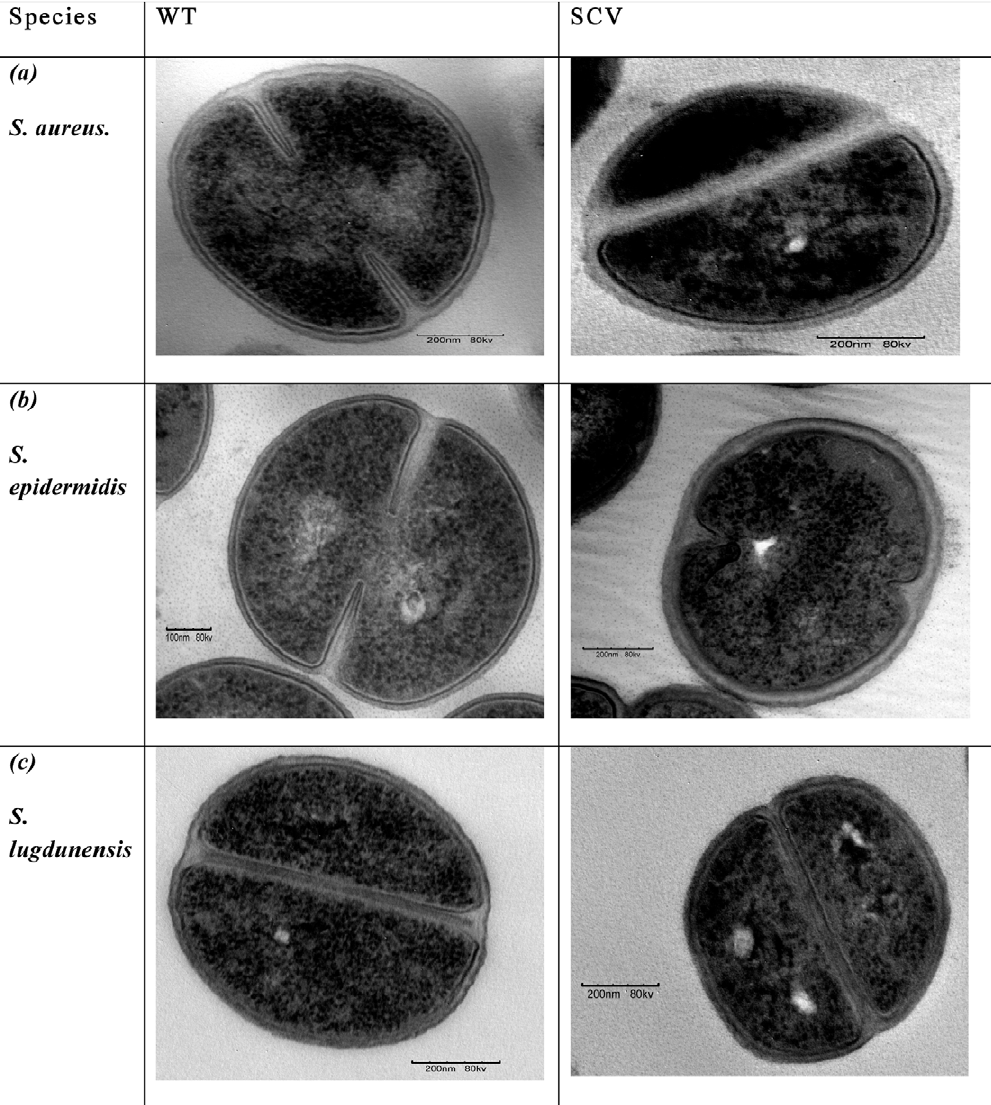
Figure 3. TEM images of (a) S.aureus , (b)S.epidermidis and (c) S.lugdunensis WT and SCV cells showing their respective ultra- structural characteristics. WT cells had clearly defined cell-walls in comparison to SCVs which had thicker, more diffuse cell-walls following